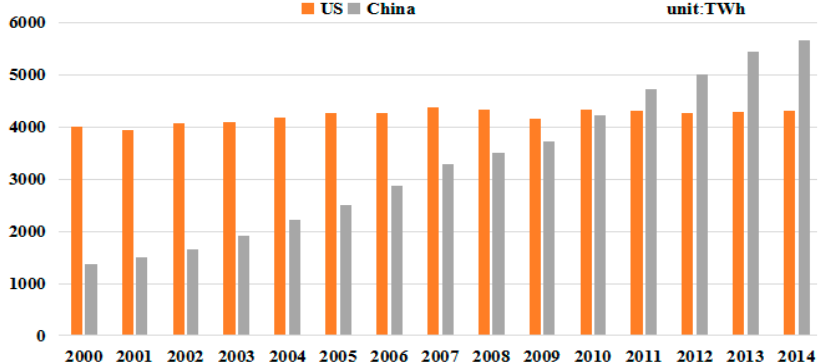
Figure 5. Comparison of electricity generation between China and the US.